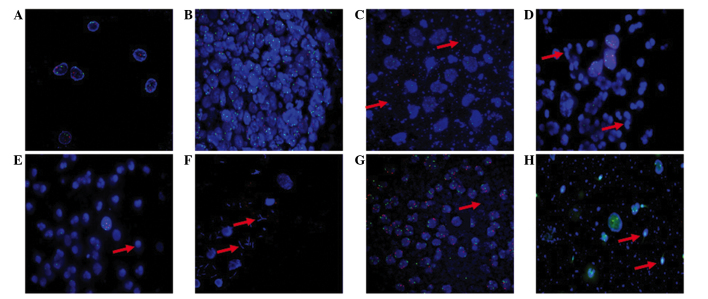
Various signal patterns were observed in the urine samples. (A) Reference urine sample. Samples in which the following observations were noted: (B) Cell density was too high, (C) large volume of mucus among cells, (D) an excessive number of neutrophils, (E) an excessive number of lymphocytes, (F) numerous bacilli among epithelial cells, (G) numerous cocci among epithelial cells and (H) an excessive number of sperm among epithelial cells.